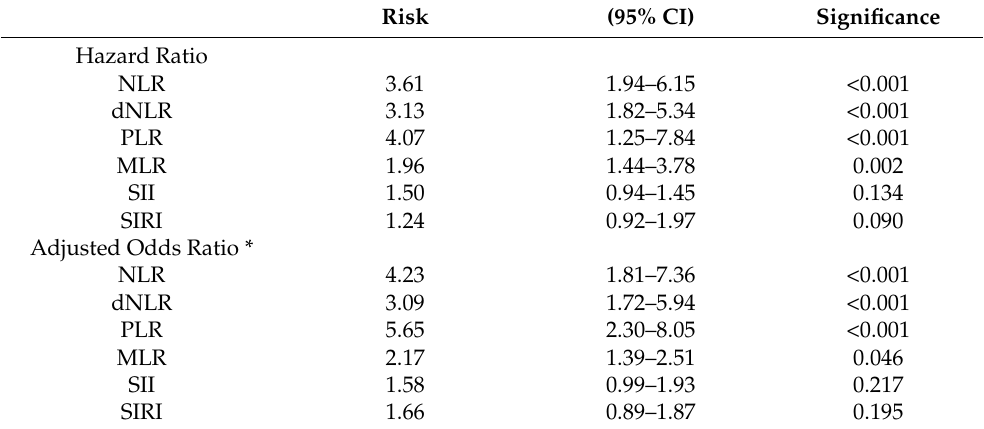
Table 4. Regression analysis for risk of premature birth in SARS-CoV-2 infected pregnant women.